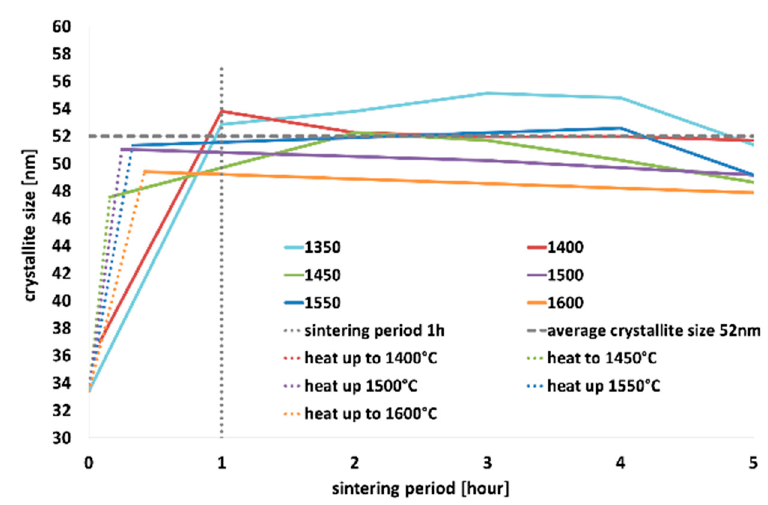
Figure 6. Influence of sintering period on crystallite size at investigated temperatures.